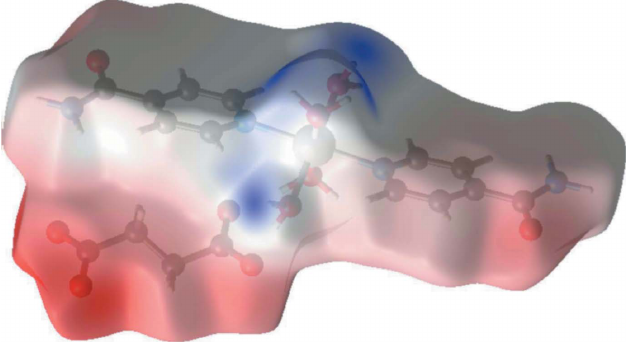
Figure 4 A view of the three-dimensional Hirshfeld surface of the title complex, plotted over the electrostatic potential